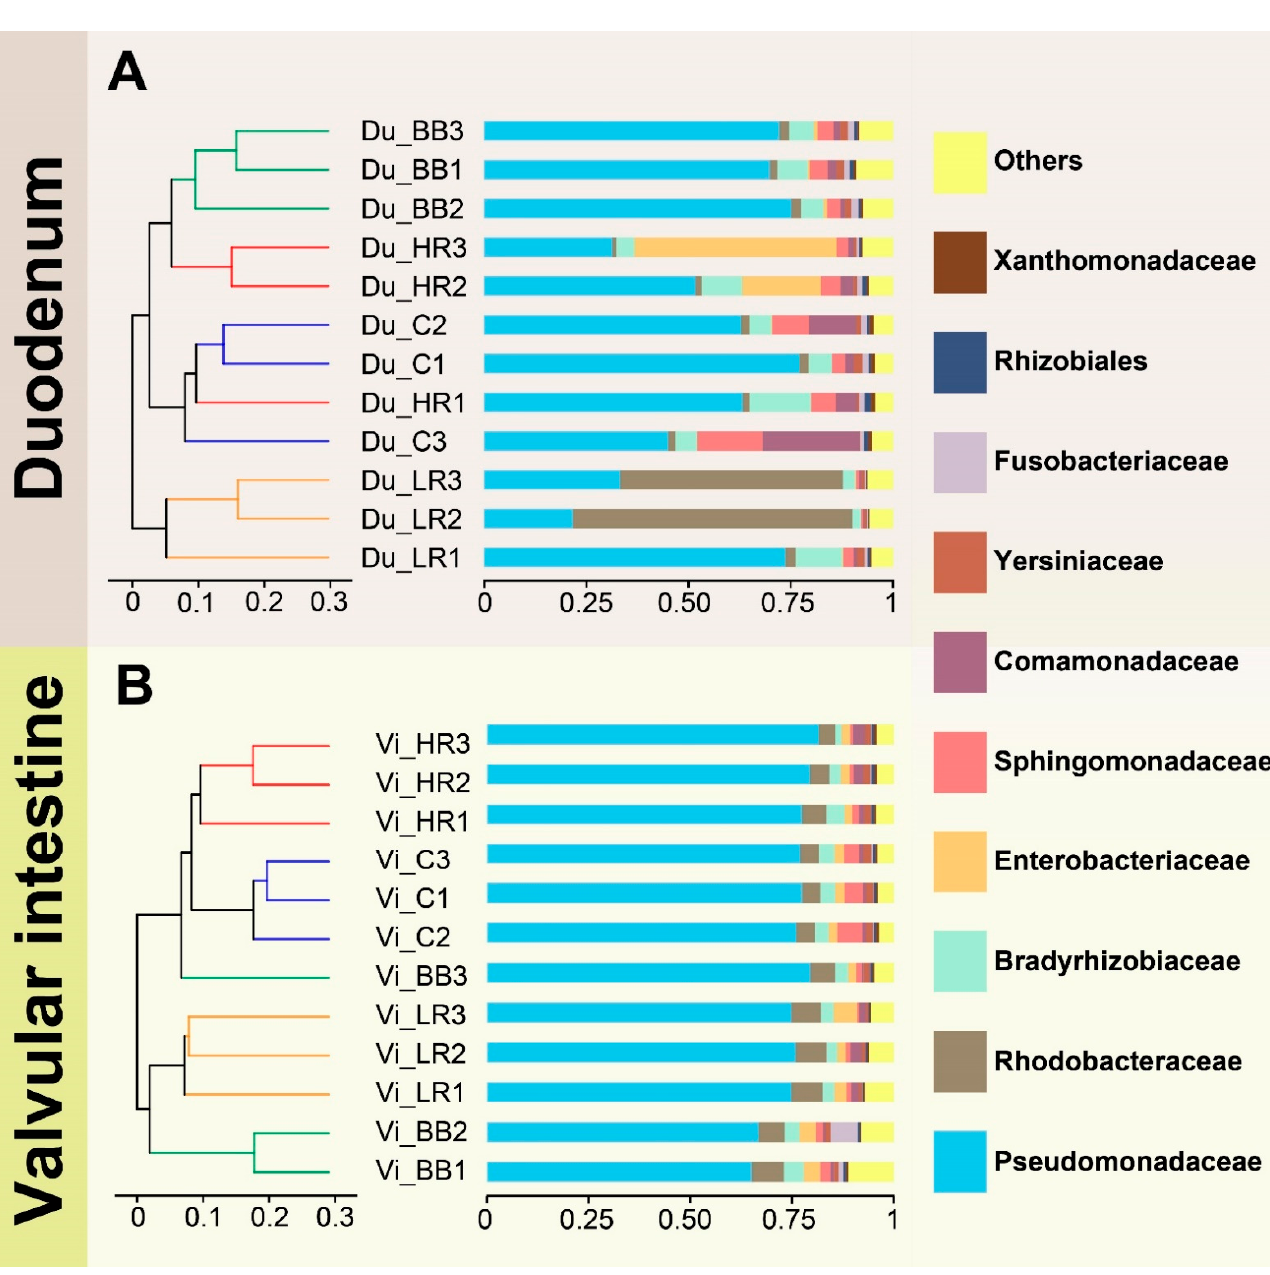
Figure 3. ( A , B ) represent hierarchical clustering trees of Siberian sturgeon duodenum and valvular families, respectively. Clustering analysis based on Bray–Curtis dissimilarity.